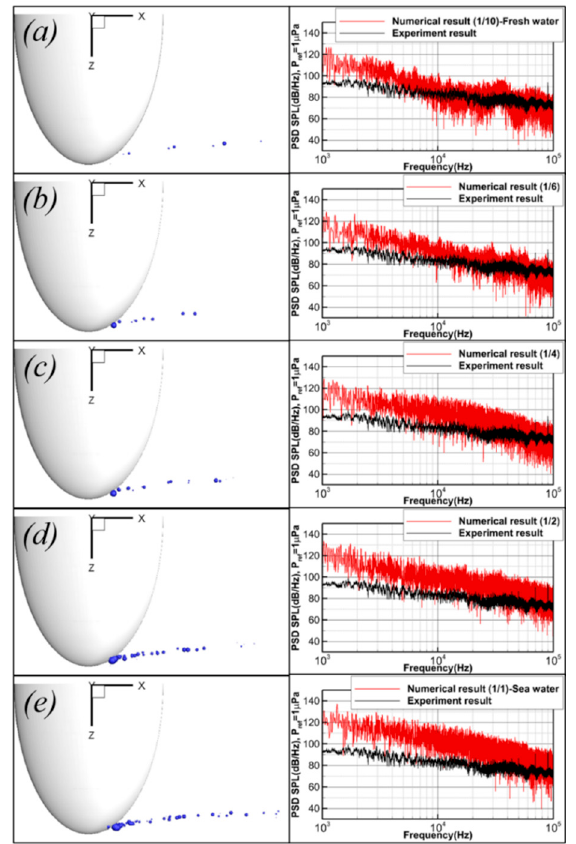
Figure 25. The number concentration density for each nuclei size.